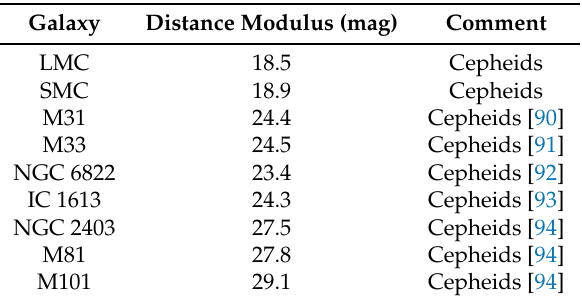
Table 2. Adopted Distance